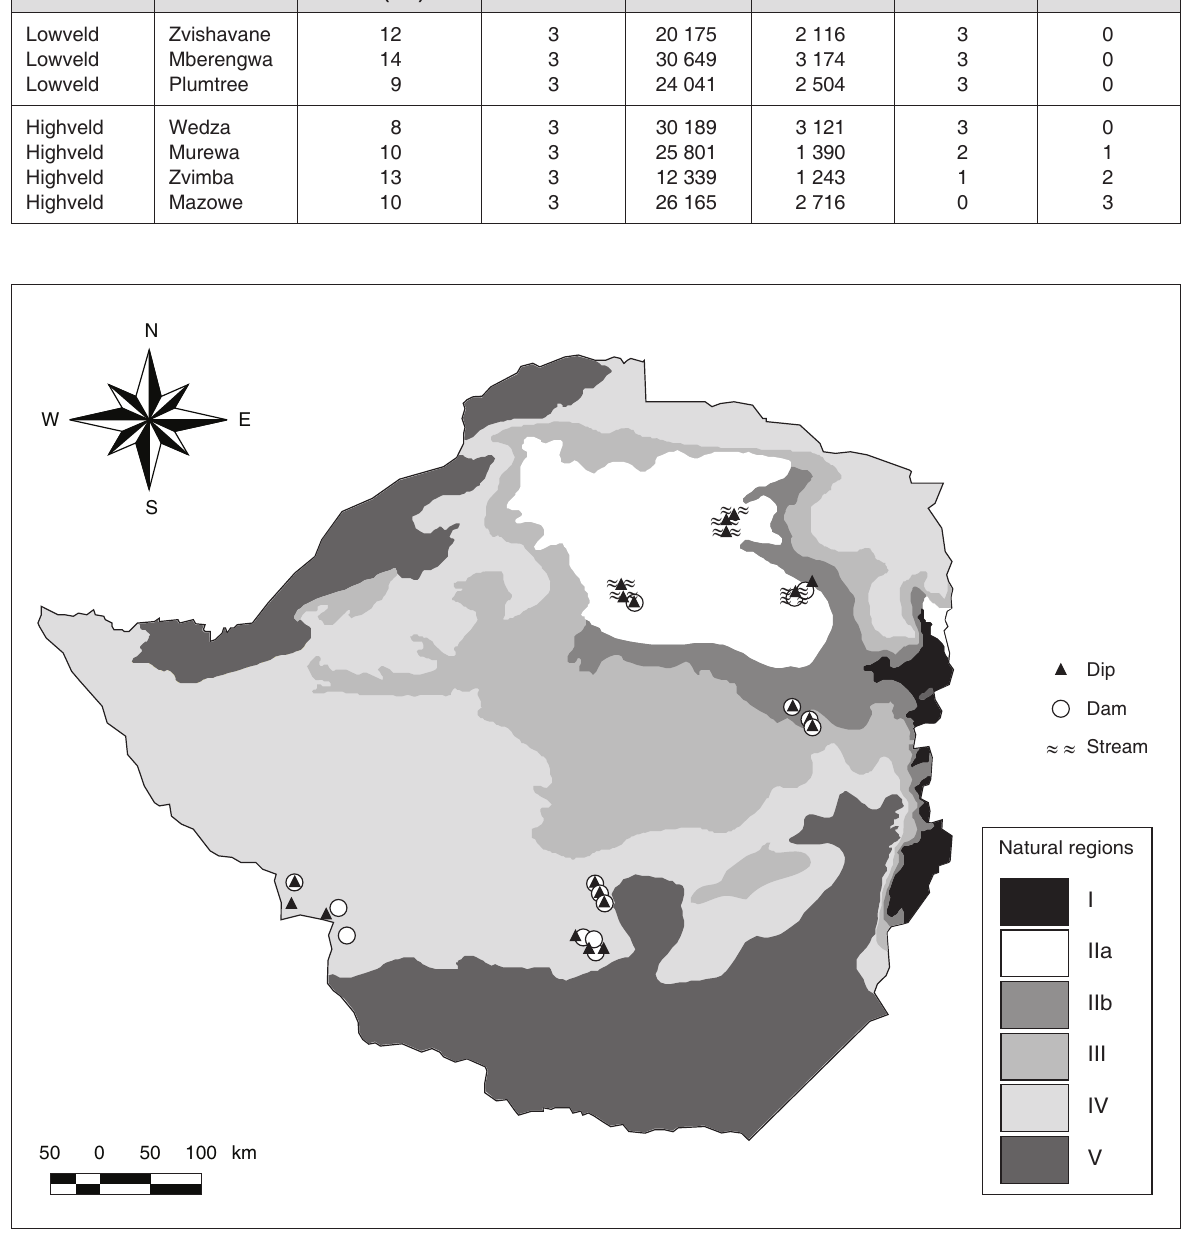
FIG. 1 Location of dips and snail habitats sampled in the different natural regions in the highveld and lowveld communal grazing areas of